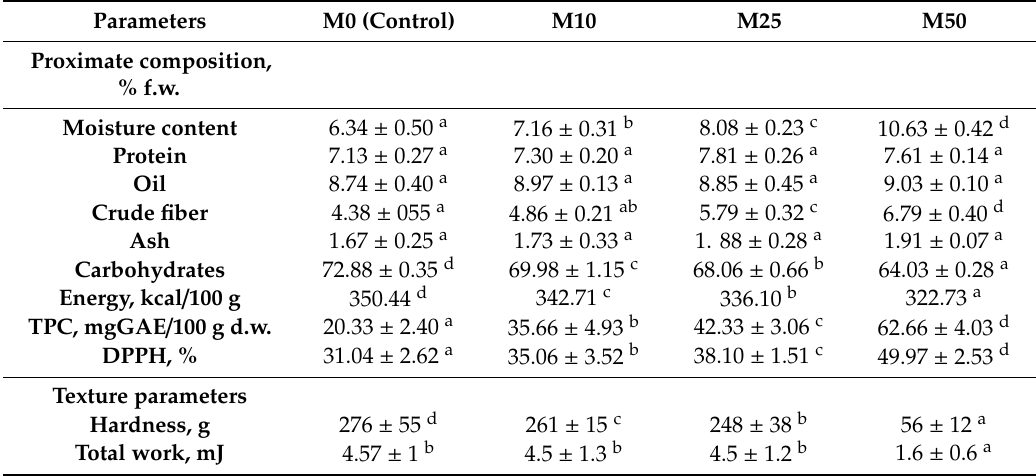
Table3. Chemicalcompositionformodifiedmacaronswithwalnutoilcakeandtheirtexturalprofileanalyses.